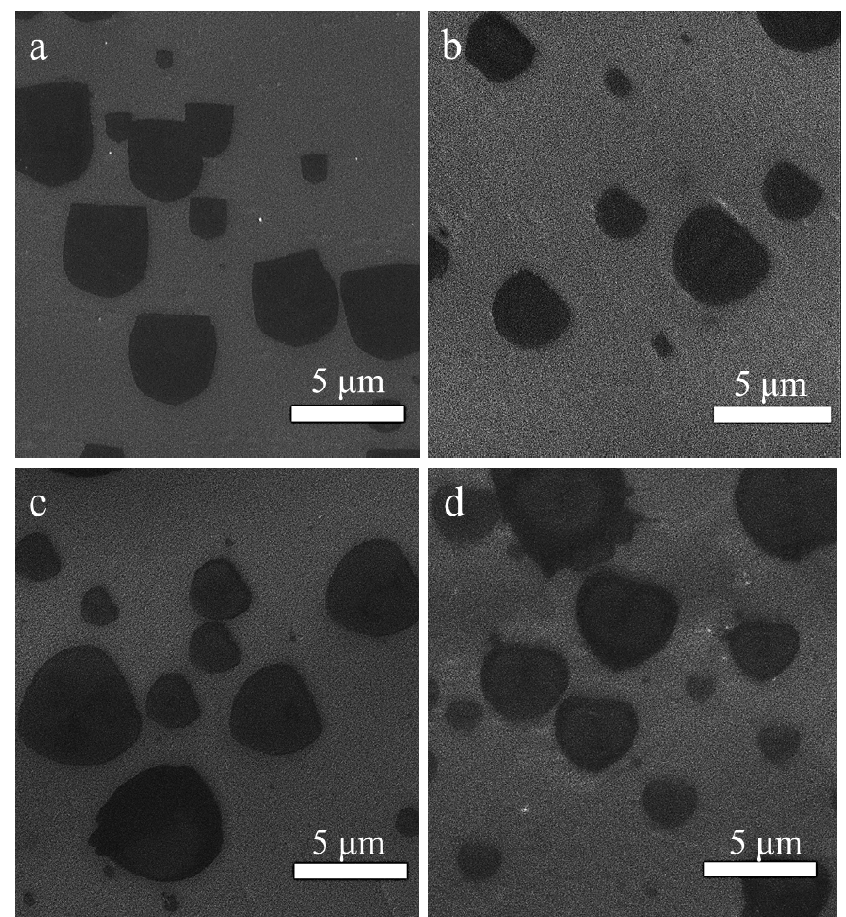
Figure 5. ( a – d ) SEM images depicting the evolution of the graphene domain growth on the copper foil at different hydrogen flow rates by atmospheric pressure CVD (75, 65, 60, and 55 sccm, respectively).